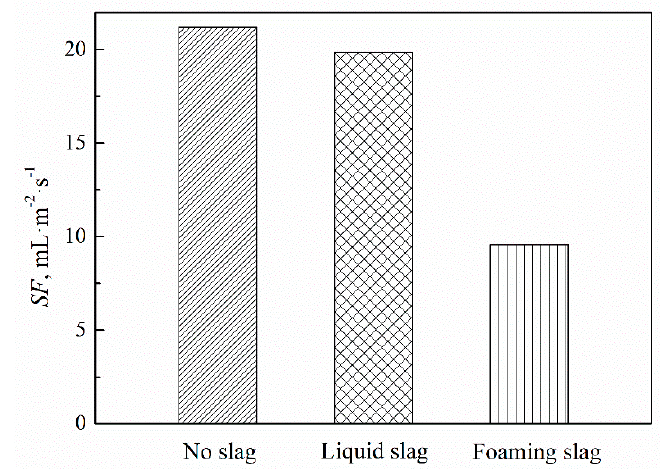
Figure 13. E ff ect of the slag on the SF in the furnace Figure 13. Effect of the slag on the SF in the furnace mouth. Figure 13. Effect of the slag on the SF in the furnace mouth.